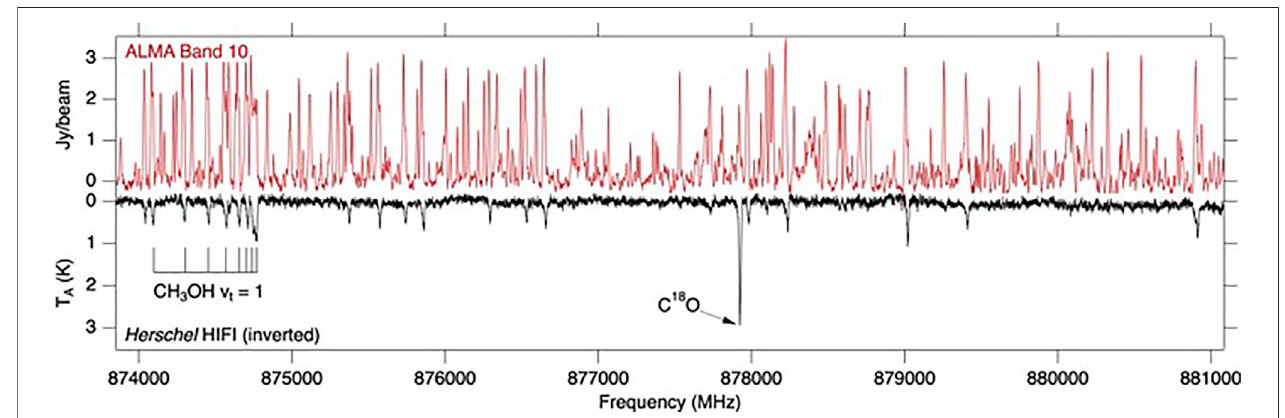
FIGURE 6 | Comparison of the spectra acquired by ALMA Band 10 and HIFI while observing the NGC 6334I region. Figure taken from McGuire et al. (2018b) and reproduced with permission from the AAS.